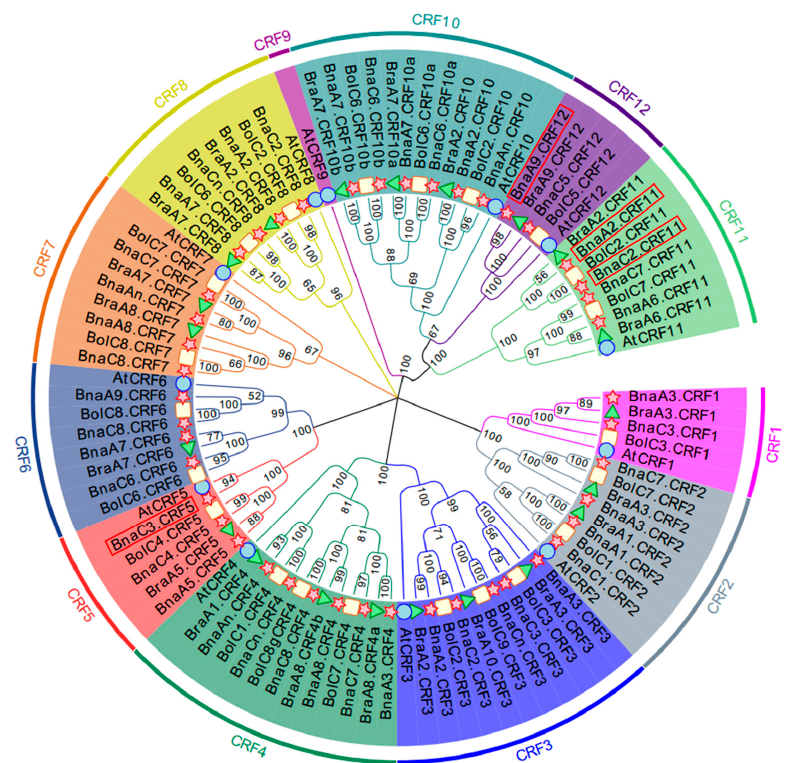
Figure 1. Phylogenetic tree of cytokinin response factor (CRF) genes in Arabidopsis thaliana and Brassica crops. Homologous genes of each CRF are distinguished by different colors. The unrooted tree was generated using ClustalW in MEGA7.0 using the full-length amino acid sequences of the 9, 44, 21, and 22 CRF proteins in A. thaliana (circle), B. napus (star), B. rapa (triangle), and B. oleracea (rectangle), respectively. Four BnaCRF genes newly identified in this research are highlighted with a red box.